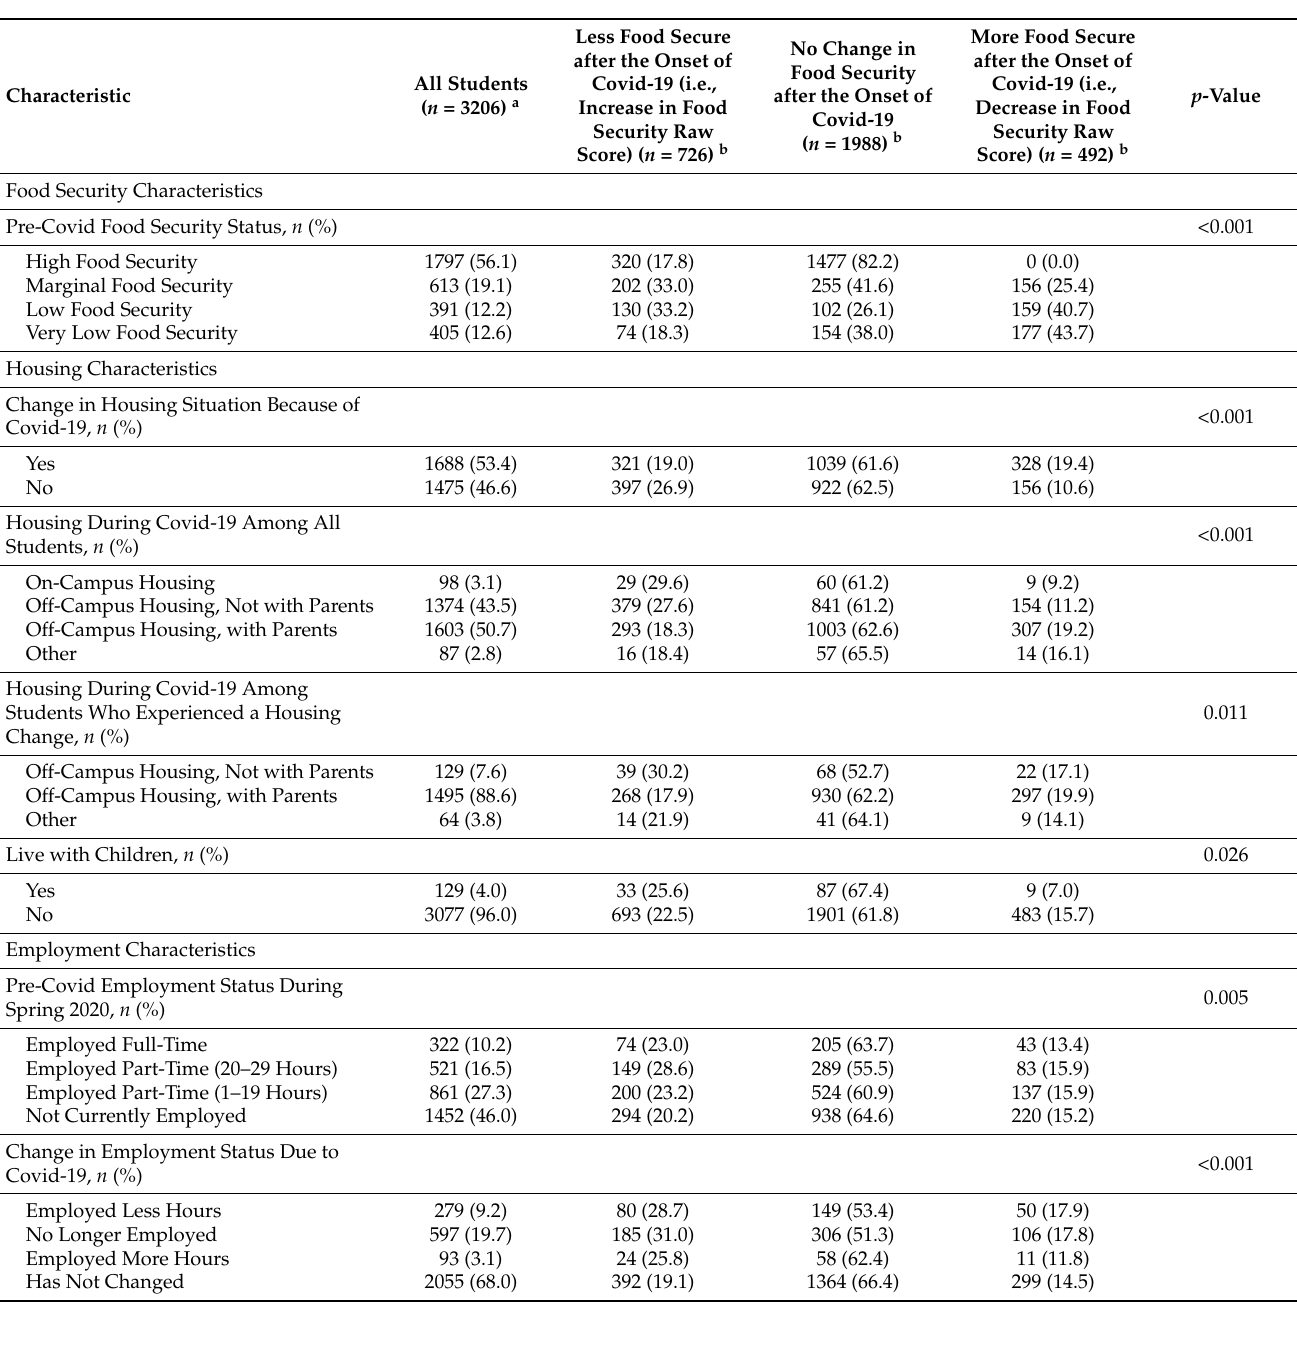
Table 3. Participant Characteristics and Associations with Changes in Food Security during